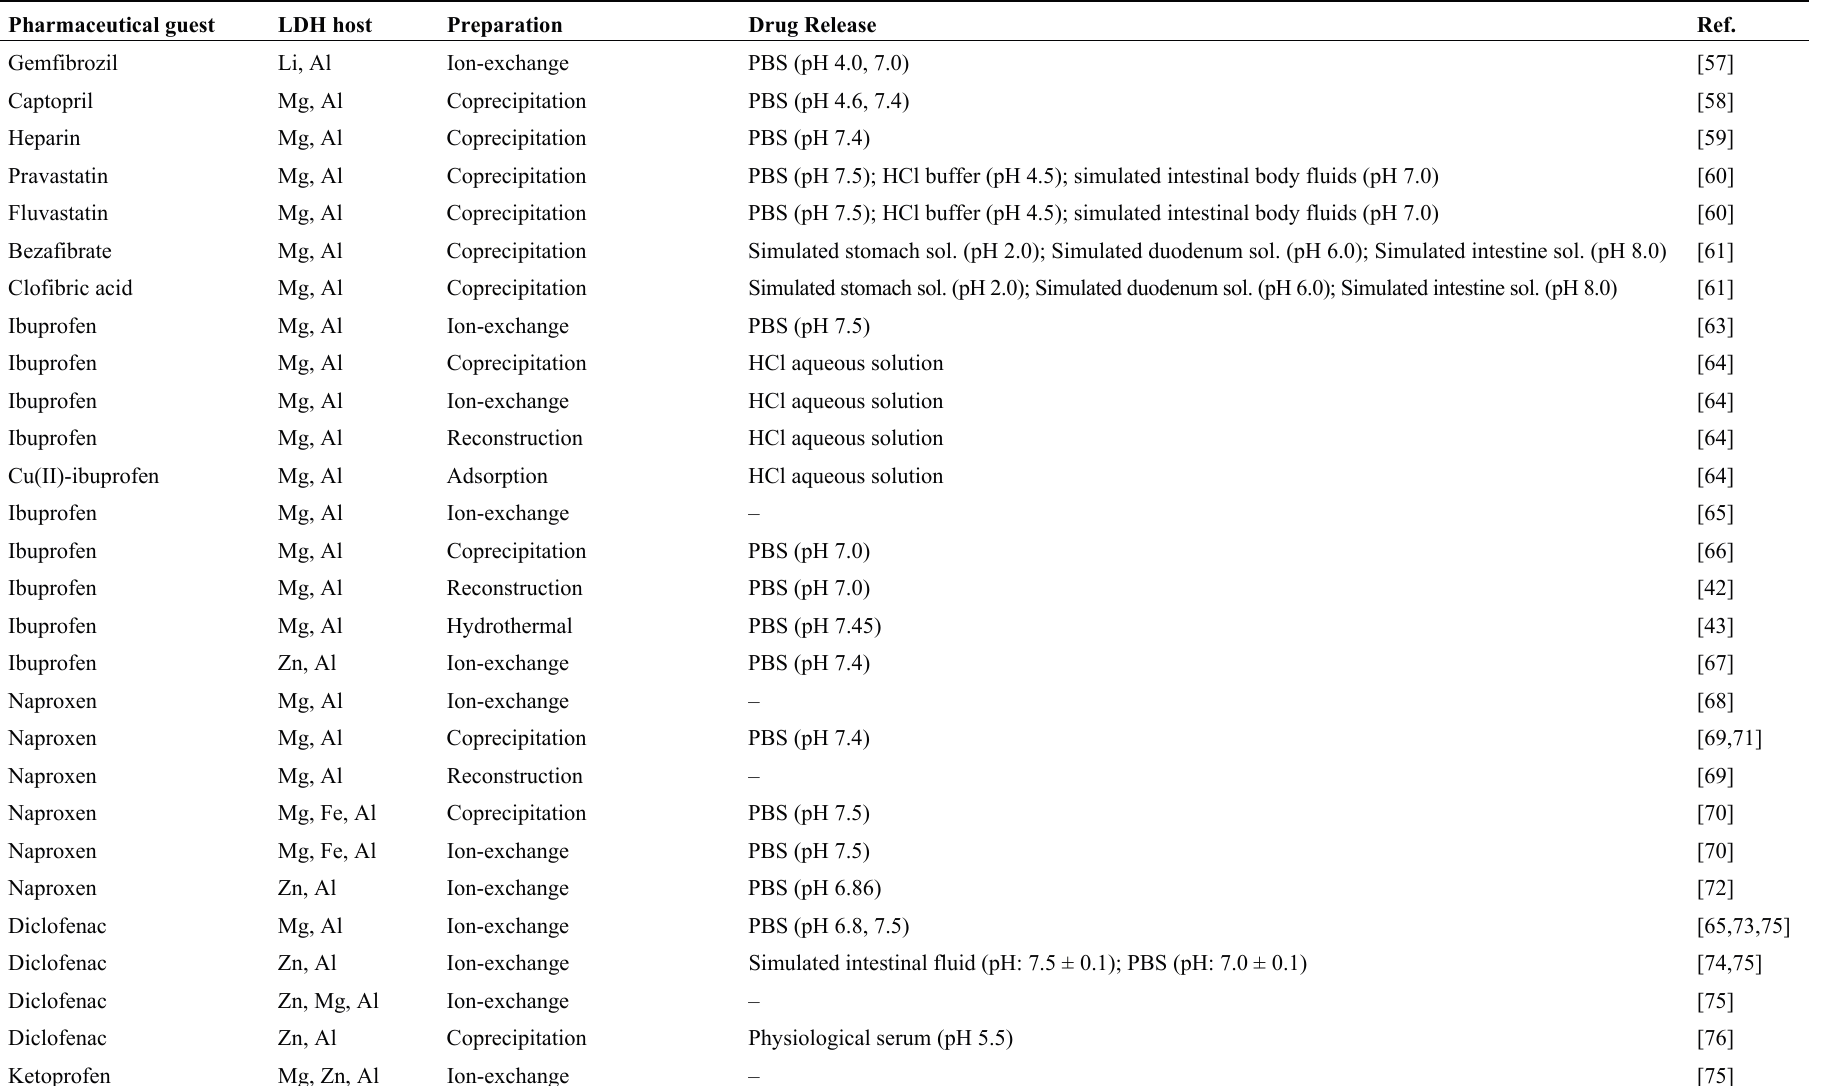
Table 1. Brief summary of LDH-based DDS reviewed in this